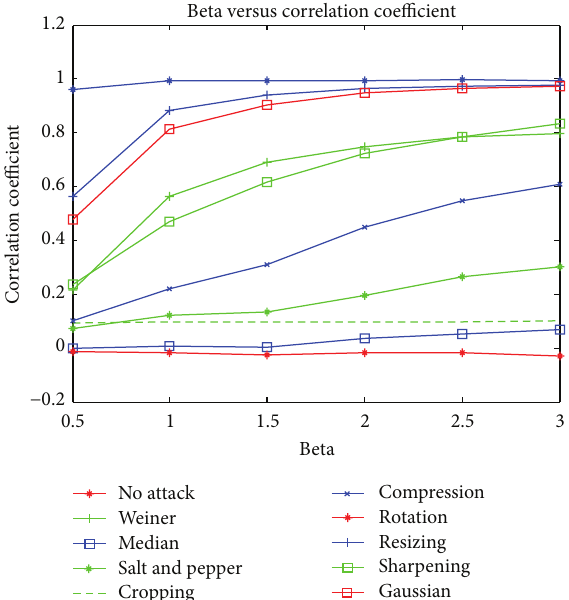
Figure 6: Relation between 𝛽 and PSNR for various attacks.